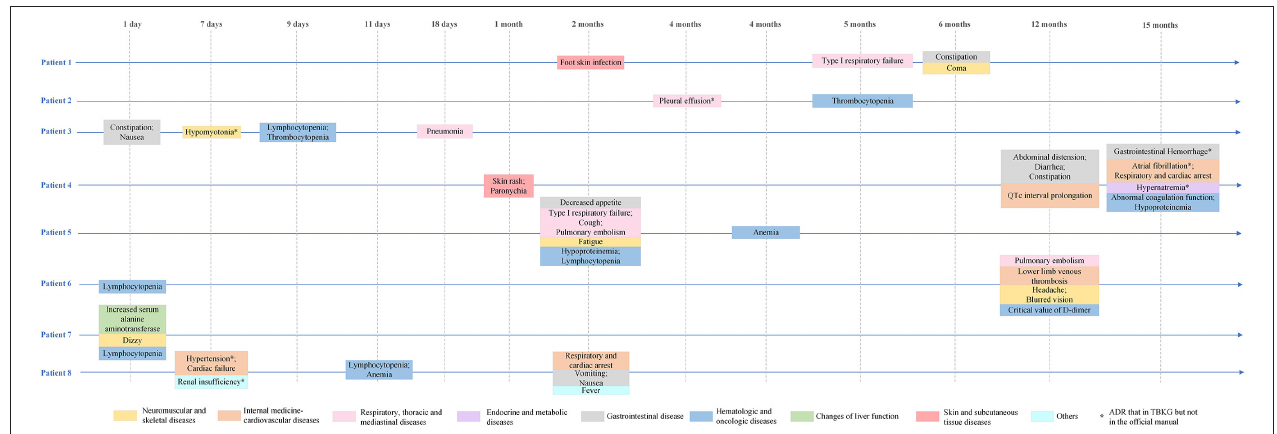
FIGURE 7 | Adverse drug reactions of clinical patients receiving osimertinib. *Not mentioned in the official manual of osimertinib, but mentioned in